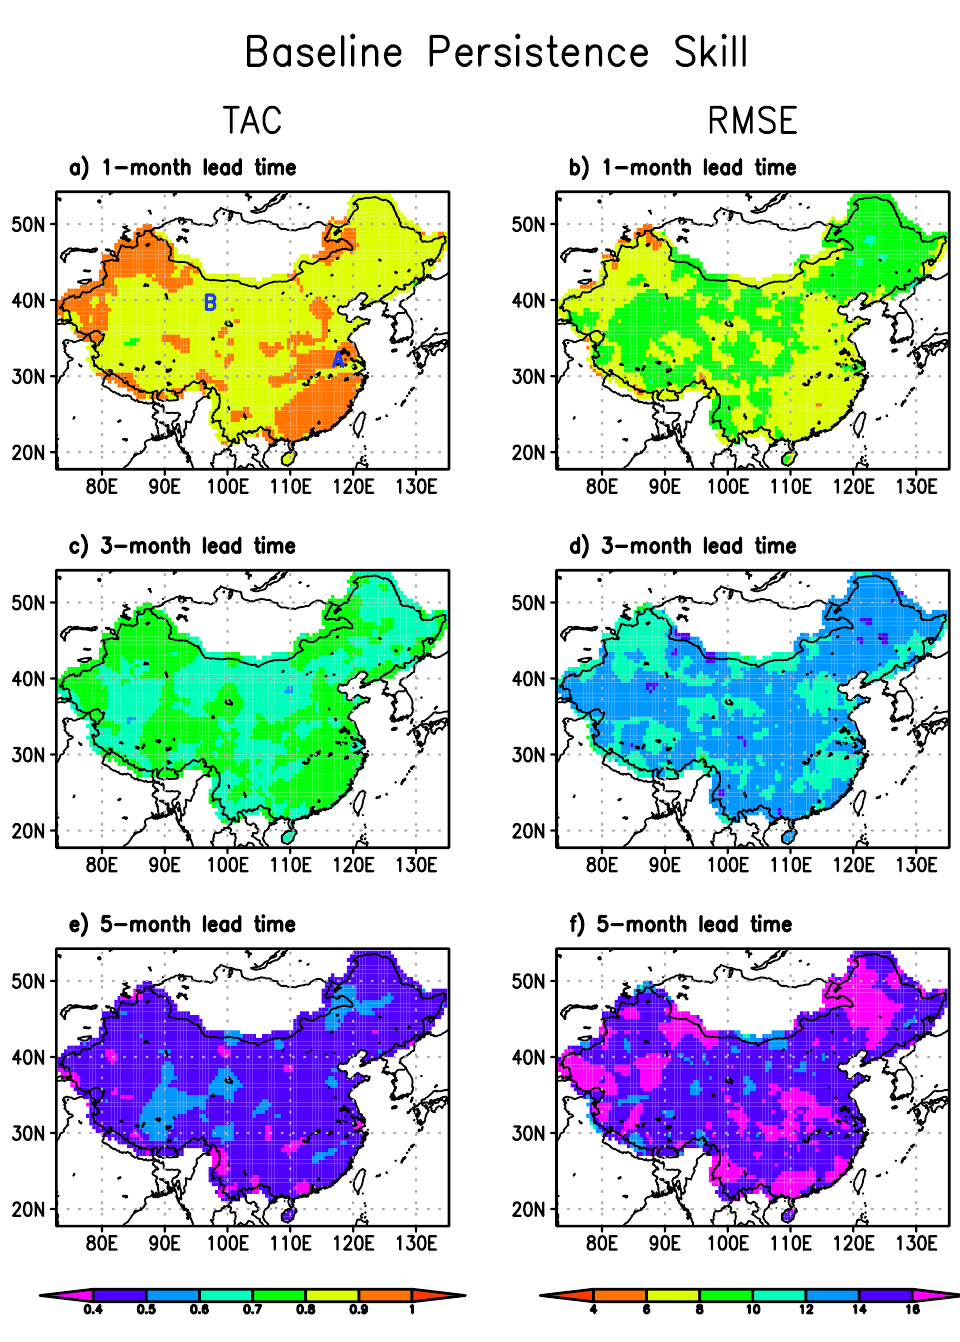
Figure 1. Skill of the baseline persistence forecast measured by temporal correlation coefficient (left column) and root mean square error (RMSE) (right column) at the 1-month (top), 3-month (middle), and 5-month lead times. Locations A and B indicated in panel ( a ) were used in later